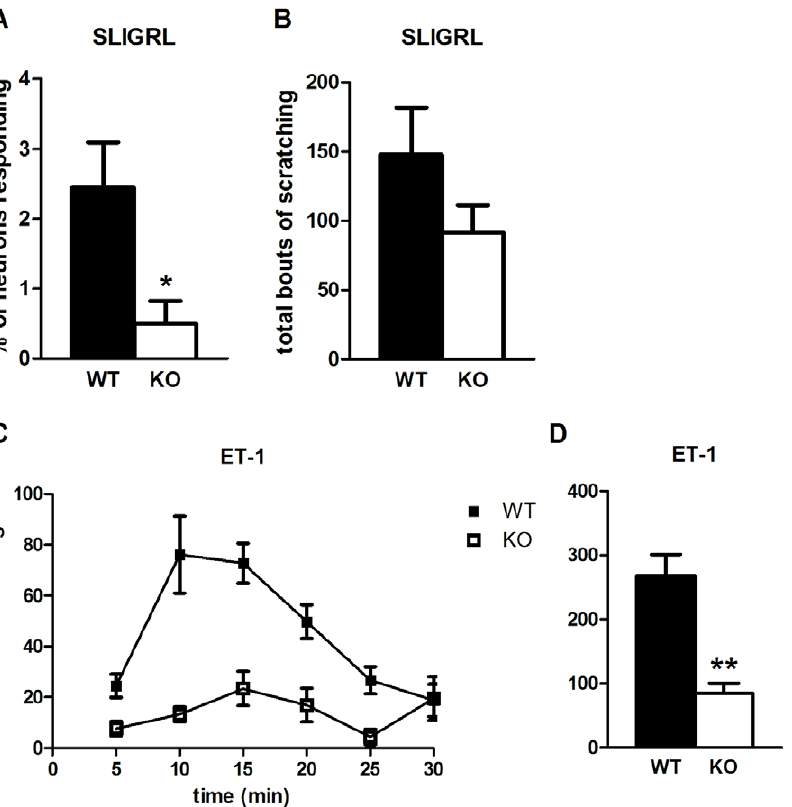
Figure 3. SLIGRL- and ET-1-induced responses are Pirt-dependent. ( A ) Cellular responses to SLIGRL (130 m M) are fewer in DRG neurons from Pirt 2 / 2 mice (n=5 per genotype). ( B ) Pirt mutants (n=11) scratch less than WT mice (n=13) upon SLIGRL injection (0.1 m mol), but the difference is not statistically significant. ( C , D ) ET-1 (10 pmol) generates a decreased behavioral response in Pirt KO (n=10) versus WT (n=9). * p , 0.05, ** p , 0.001; two-tailed unpaired t